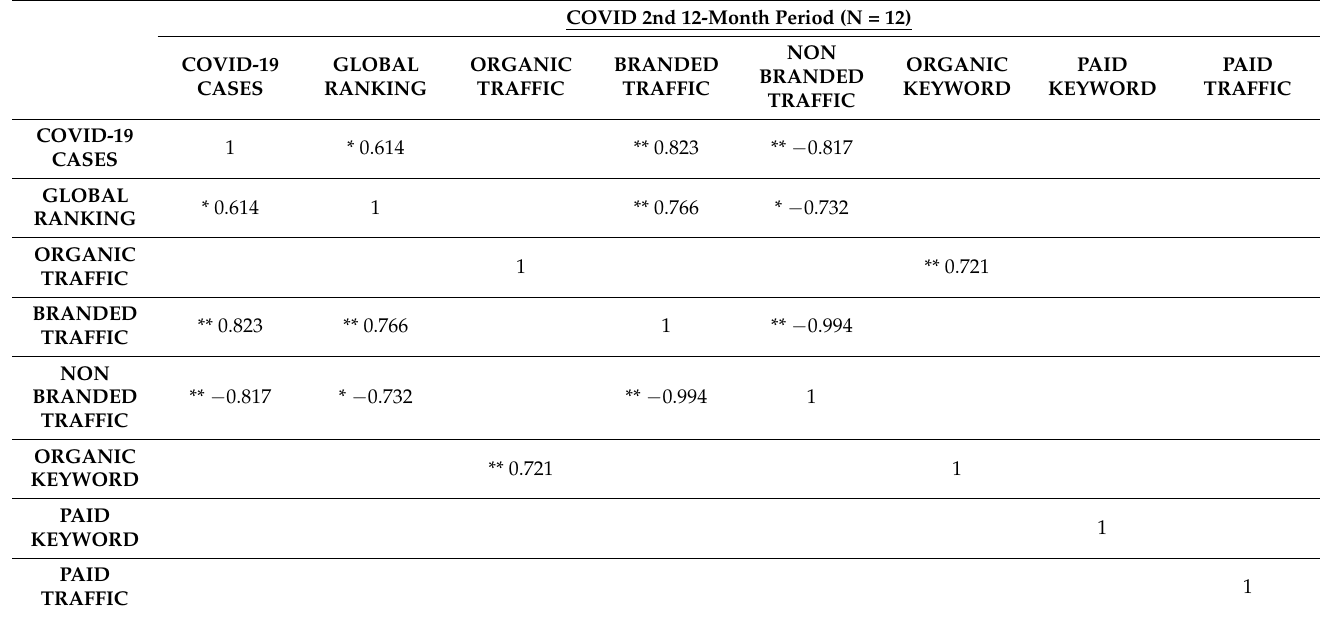
Table 6. Statistically significant correlation matrix after PCC–r analysis (COVID 2nd 12-month